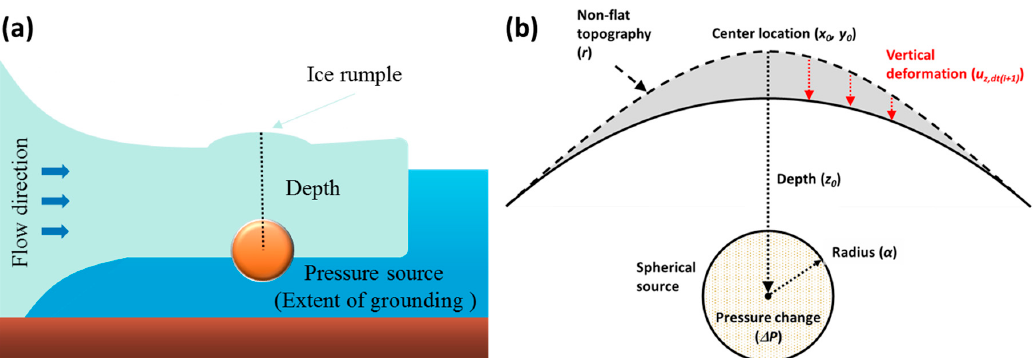
Figure 2. Schematic drawings of ( a ) an ice rumple (with the extent of grounding represented by an idealized spherical pressure source) and ( b ) the elastic deformation model with a finite spherical pressure source. The initial surface is not flat, thus the radial distance from the center of a sphere to the surface varies.